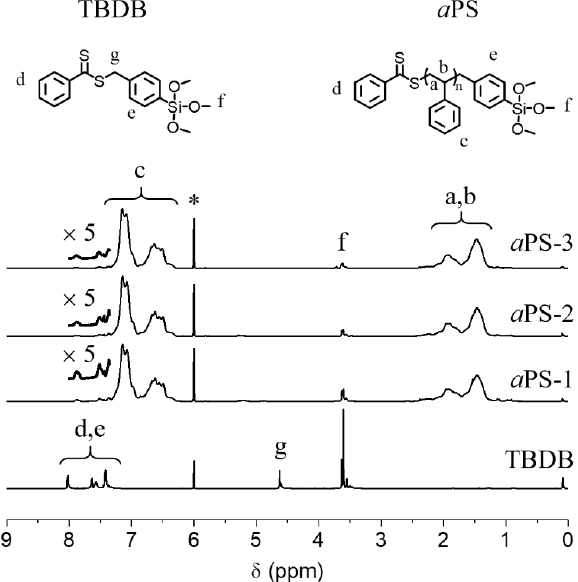
Figure 2. 1 H-NMR spectra of TBDB and methoxysilane-terminated a PSes ( a PS arms). Solvent (*): 1,1,2,2-tetrachloroethane- d 2 . Table 1. Characterization of a PS arm